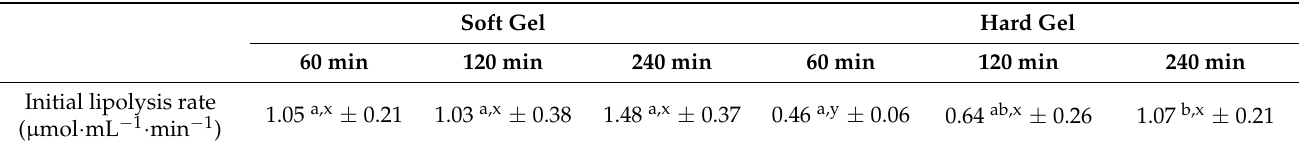
Table 1. Initial lipolysis rate ( µ mol · mL − 1 · min − 1 ) of emptied gastric digesta during intestinal digestion. Results are shown as mean ± standard deviation of three